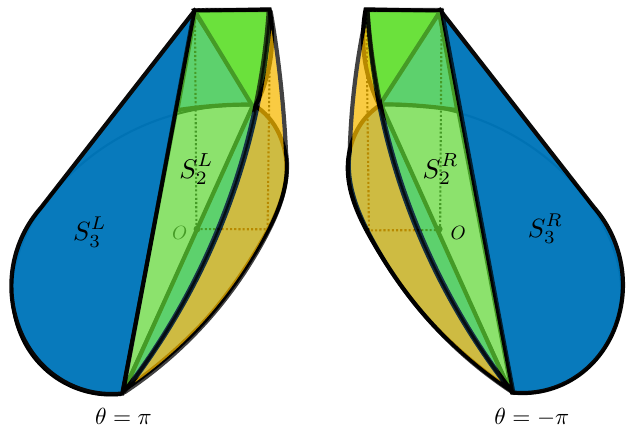
L and S R are 3 . S 3 3 and S R are the additional 2 2